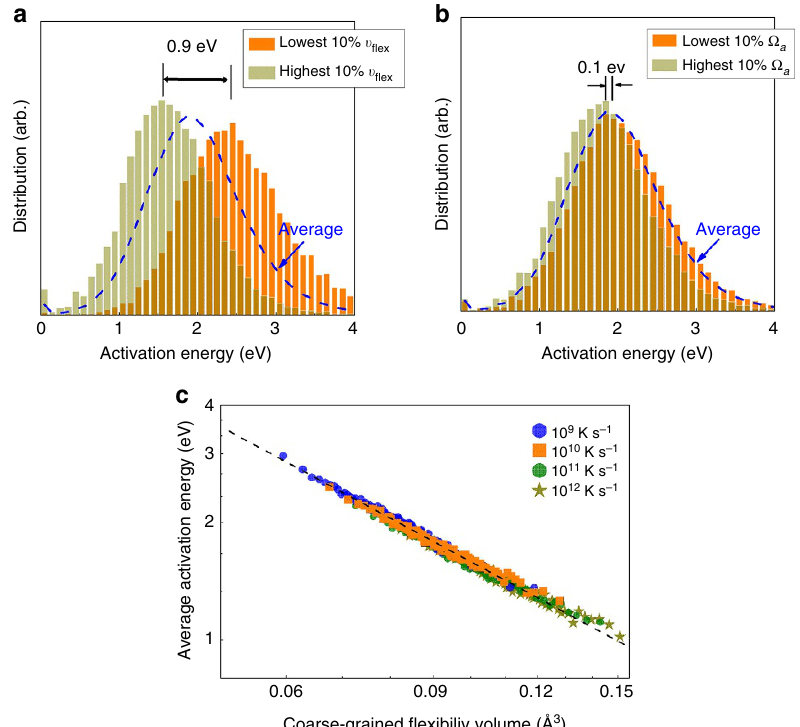
Figure 4 | Flexibility volume correlates strongly with thermally activated relaxation events. Distribution of activation energy in a Cu 64 Zr 36 MG (Sample G28, with 10,000 atoms and the cooling rate of 10 9 Ks -1 ) characterized using ARTnouveau. The activated relaxation events are for (Cu and Zr) atoms in the centre of their coordination polyhedra. The blue line is for the distribution of activation energy in the entire sample, whereas ( a ) shows the two groups with the highest and lowest 10% of the values for the flexibility volume ( u flex, i ), and ( b ) is for the two groups with the highest and lowest 10% of the values for the atomic volume ( O a, i ) . For ( a ) and ( b ) both Cu and Zr atoms in the distribution are counted to avoid possible biases due to different chemical elements (that is, for the 10% of the atoms with the highest values of u flex, i , we select both the top 10% Cu and the top 10% Zr atoms). Here each curve is normalized by the total number of activated events sampled by the entire group of atoms involved in the distribution. While the two groups almost overlap in the case of O a, i , the bifurcation between the two groups is obvious in the u flex, i case, with the two peaks separated by 0.90eV. ( c ) All the atoms are sorted based on coarse-grained values of u flex, i (see text), into bins each containing 1% of the atoms. An average activation energy is then calculated for the atoms in each bin, and plotted to demonstrate the strong correlation with the coarse-grained flexibility volume. The Cu 64 Zr 36 MG samples used in this plot were produced at several cooling